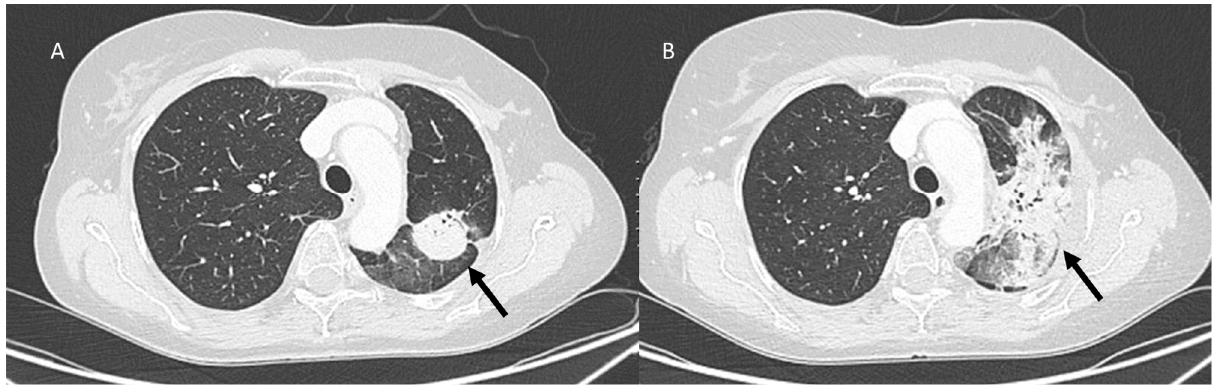
Figure 6. CT assessment of radiation pneumonia RP in RT-treated lung cancer. In ( A ), ground glass opacities (arrow) at about 8 weeks following completion of radiotherapy. In ( B ), consolidative pattern (arrow) at 12 weeks.